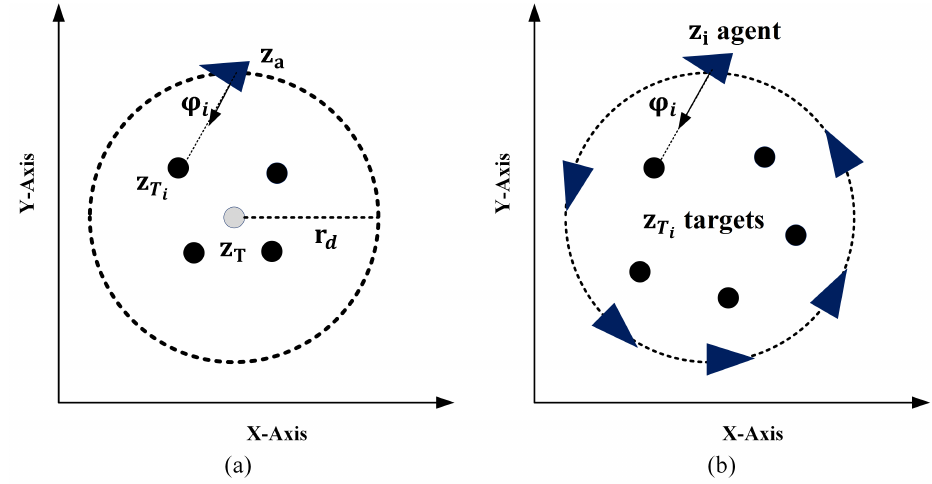
Figure 5. Circular formation: ( a ) a single agent with multiple targets; ( b ) group of agents with multiple